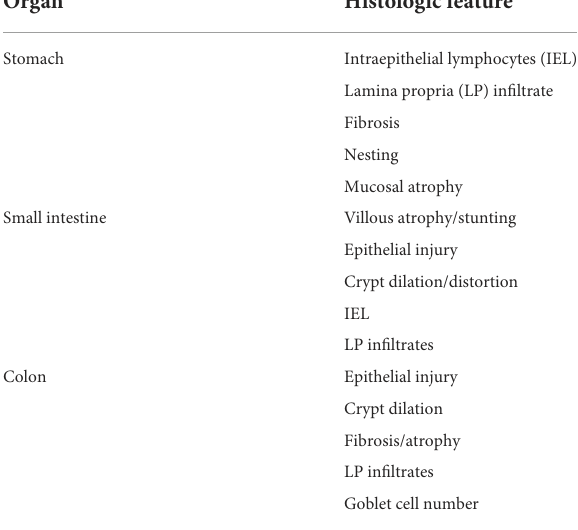
TABLE 2 Histopathologic features of the simplified histopathologic model for gastrointestinal inflammation [from (157)].